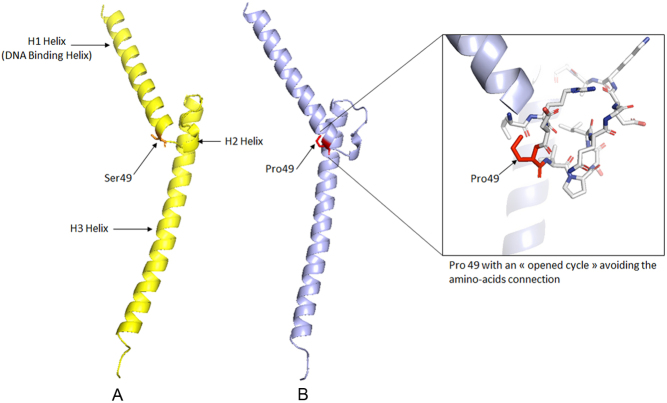
(A) 3D structure of the human native MAX protein (pdb code: 1AN2) (amino acids 22–104); (B) 3D structural prediction of the human Ser49Pro mutated MAX protein (amino acids 22–104).